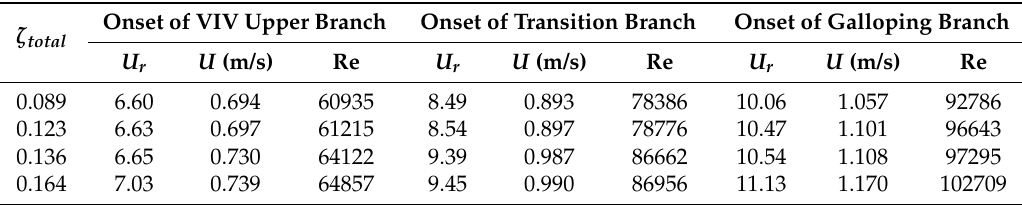
Table 4. U r , U and Re for onsets of the upper, lower and transition